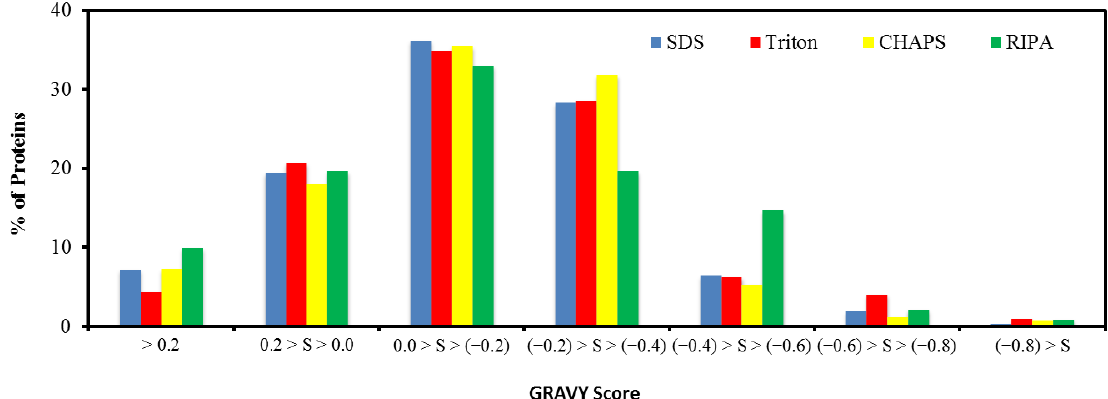
Figure 5. Distribution of the protein grand average of hydropathy (GRAVY)